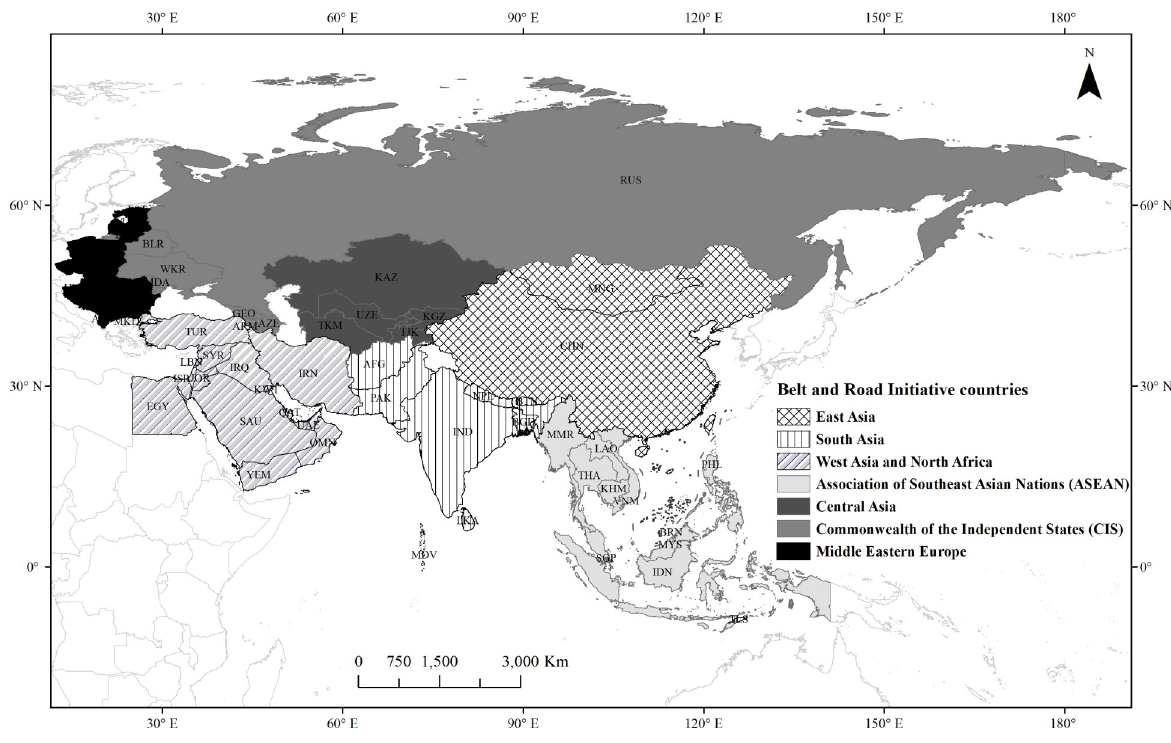
Fig 1. Geographic location of the BRI